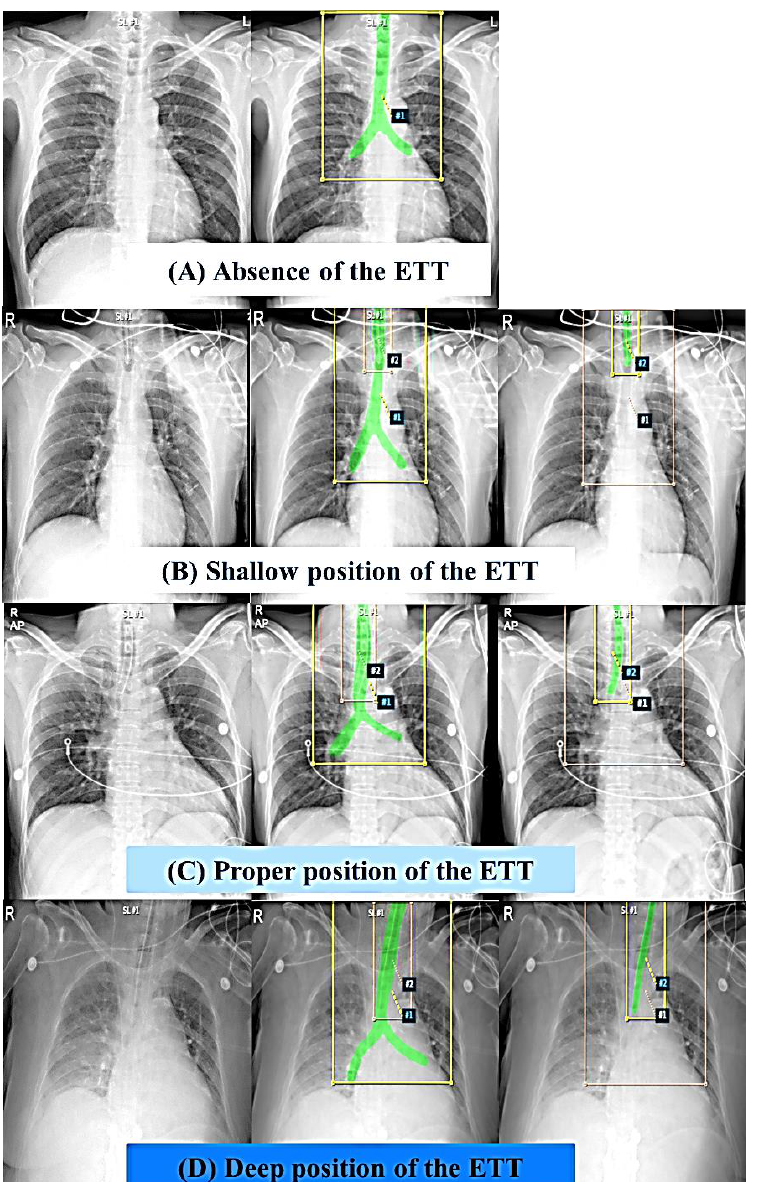
Figure 2. Segmentation of the trachea and the ETT on images according to four labels. ( A ) Absence of the ETT. ( B ) Shallow position of the ETT. ( C ) Proper position of the ETT. ( D ) Deep position of the ETT. Both the trachea and ETT were segmented on images with ETT, whereas only the trachea was segmented on images without ETT, and these segmented images were stored as Nifty (Neuroimag- ing Informatics Technology